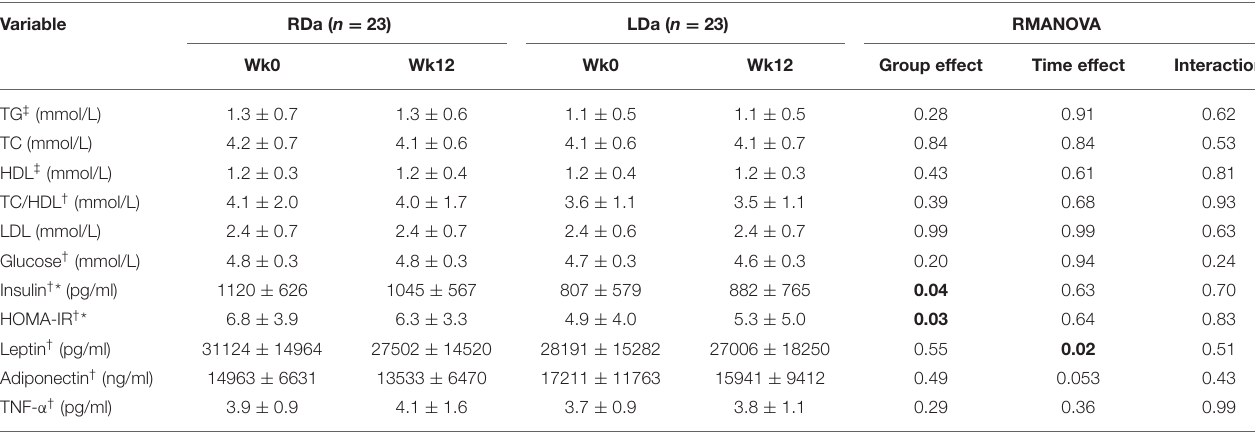
TABLE 3 | Cardiometabolic disease risk variables for the participants in the RDa and LDa groups at week 0 to week 12 of the intervention. Variable